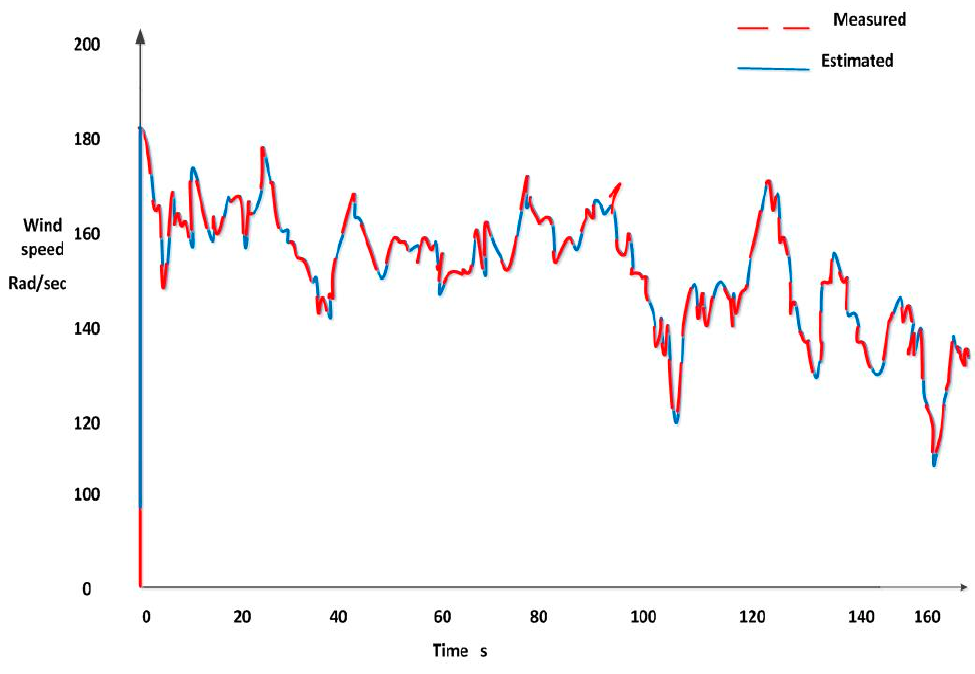
Figure 8. The wind speed estimated curve.